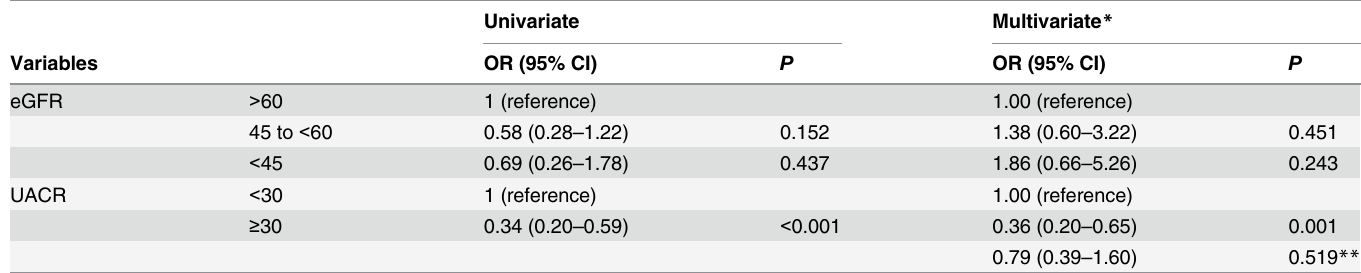
Table 3. Logistic regression analysis for good 6-month outcomes (modified Rankin scale score 0 –